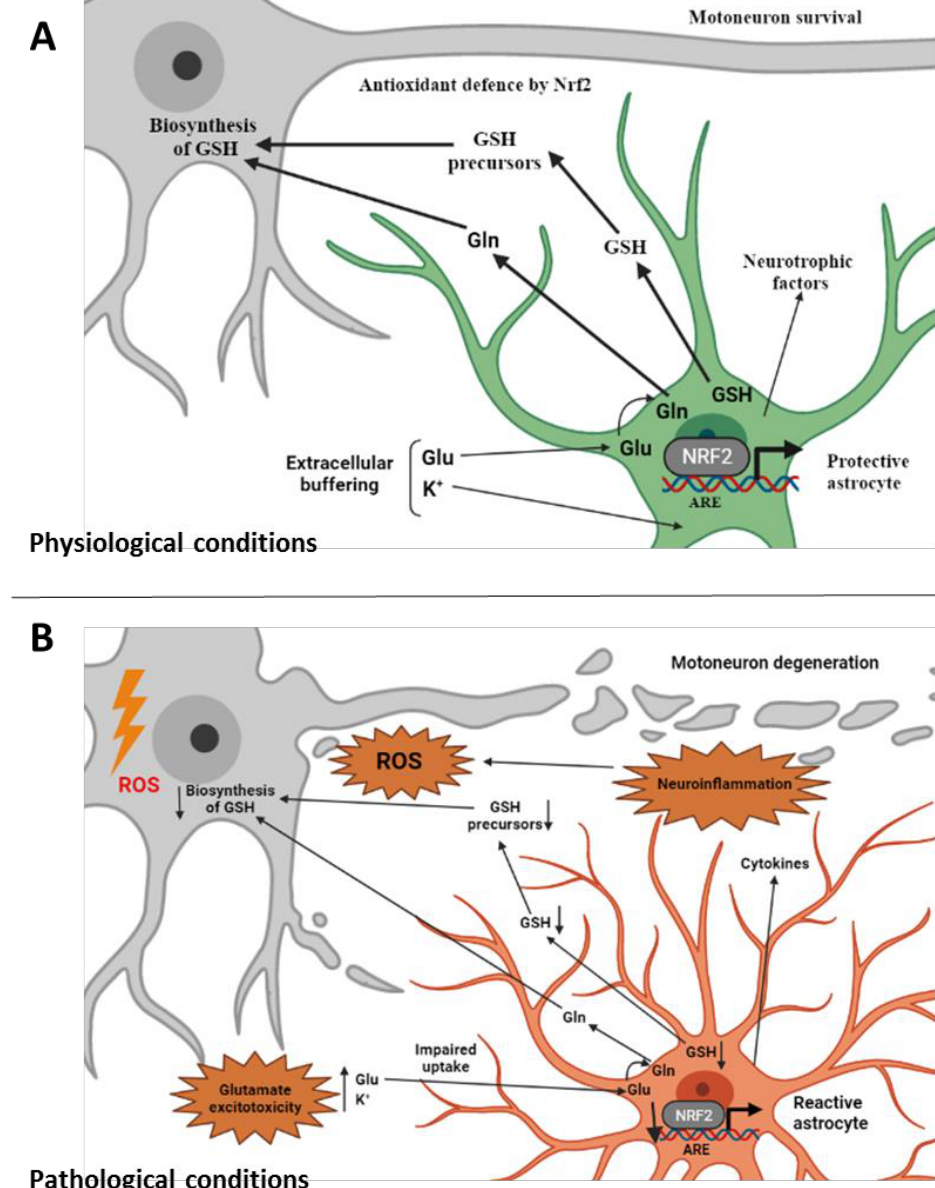
Figure 1. Involvement of non-cell-autonomous processes in ALS. ( A ) Under physiological conditions astrocytes perform a variety of neuroprotective tasks toward motoneurons from axon guidance and synaptic support, to the control of the blood brain barrier and blood flow, from the maintenance of extracellular potassium levels to the removal of the neurotransmitter glutamate. Astrocytes provide Nrf2-mediated antioxidant protection of motoneurons by supplying GSH and GSH precursors to motoneurons thus protecting them from oxidative stress [81]. ( B ) Under ALS-related pathological conditions, astrocytes change their morphology and properties and become “reactive astrocytes”. They release toxic factors and inflammatory mediators and promote glutamate excitotoxicity [16]. Impairment in the Nrf2 pathway at the astrocytic level, which does not allow the supply of GSH and its metabolites to motoneurons, is also associated with reactive astrocytes [1]. ALS, amyotrophic lateral sclerosis; ROS, reactive oxygen species; GSH, reduced glutathione; Gln, glutamine; Glu, glutamate; Nrf2, nuclear factor erythroid 2 – related factor 2; ARE, antioxidant responsive element (created with BioRender.com, accessed on 17 February 2022).